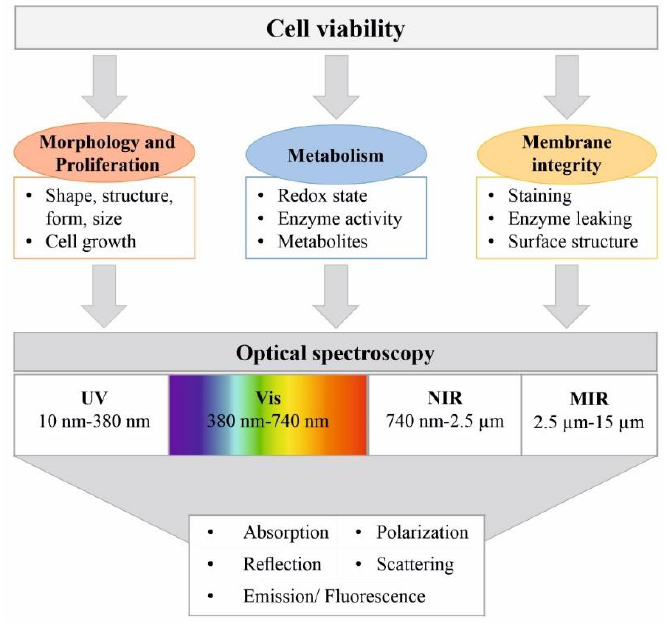
Figure 1. Application of spectroscopic methods for cell viability determination. Changes in cell morphology, metabolism and membrane integrity due to a change in cell viability can be detected via spectroscopic methods. Various optical properties in specific wavelength ranges can be exploited for this purpose.